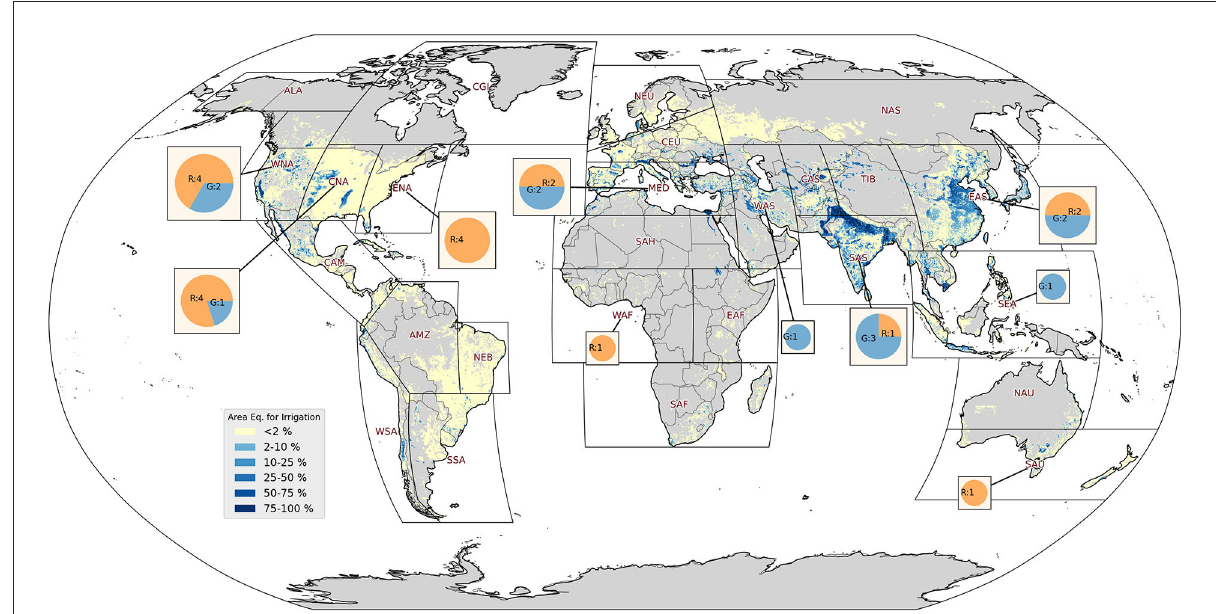
FIGURE2 Map of the area equipped for irrigation by Siebert et al. (2013). Pie charts representing the number of studies that report irrigation water amounts for each SREX area, divided in global (blue) and regional